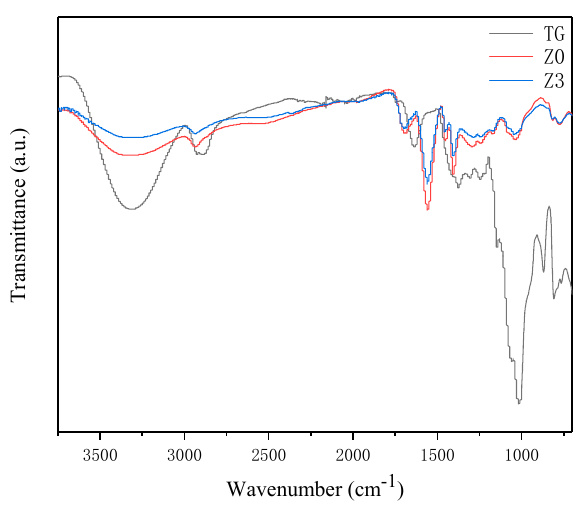
Figure 2. FTIR spectra of the TG, Z0 and Z3.